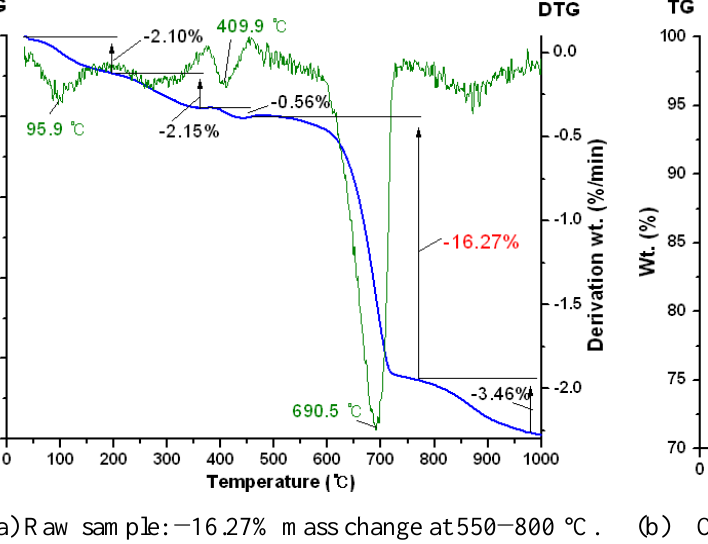
(b) Carbonated sample: − 19.74% mass change at 550 − 800